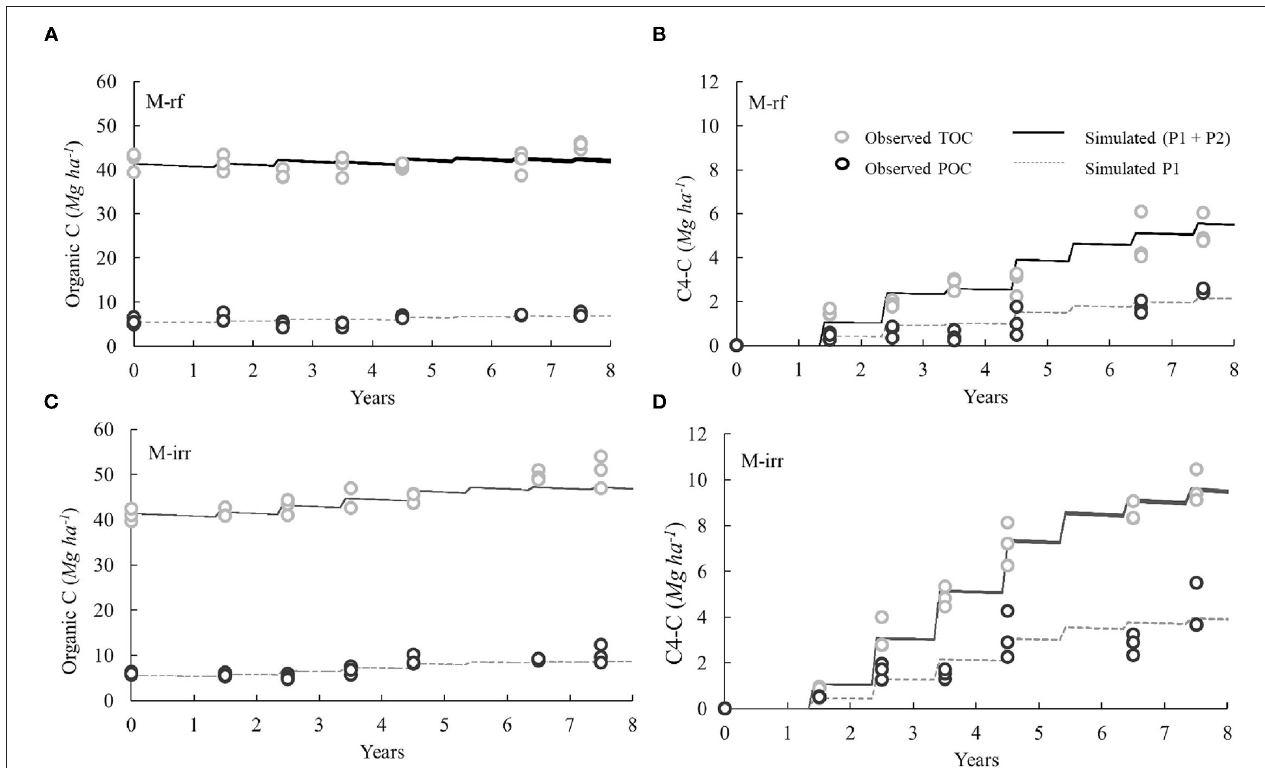
FIGURE 7 | Simulations of C and C4 stocks dynamics in P1 (gray dashed lines) and (P1 + P2) (dark lines) with the parallel model. The 50 best fits are represented. TOC (gray dots) and POC (dark dots) observed data are also displayed ( n = 3). Organic C (A) , C4-C stocks (B) , in M-rf (maize, rainfed) on top panels and organic C (C) , and C4-C stocks (D) in M-irr (maize, irrigated) on bottom